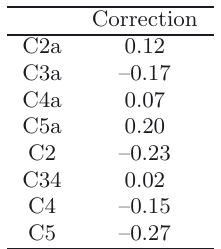
Table 2. Measured deviations on the manufacturing dimen- sions.